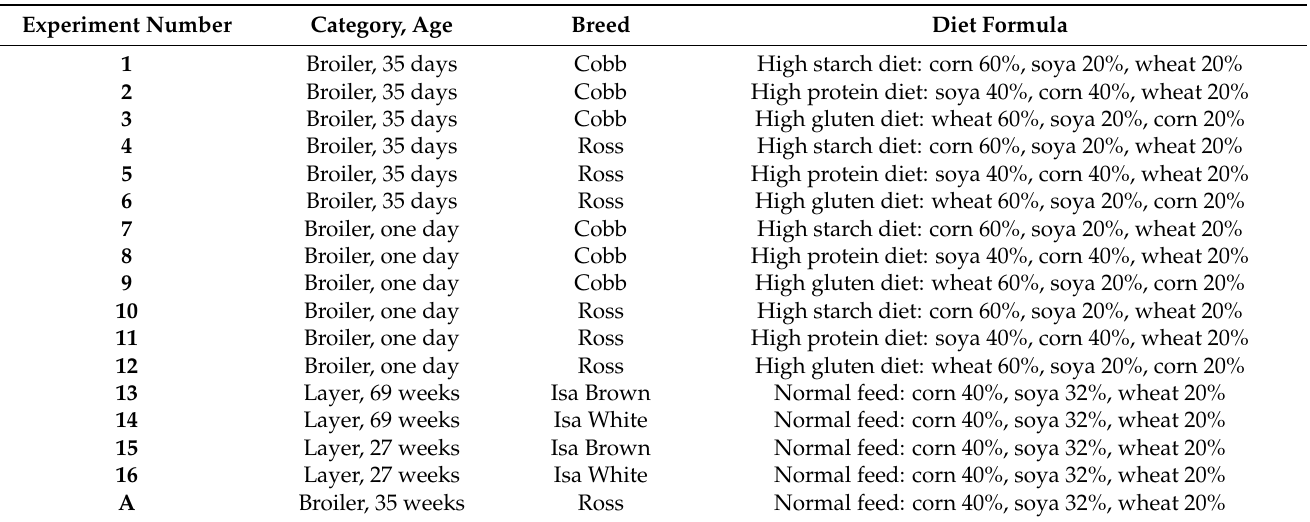
Table 3. List of coded experiments numbered according to age, breed and diet formula of the broilers and hens deprived of any antibiotics and feed additives. The A-coded sample refers to non-antibiotic-free commercial